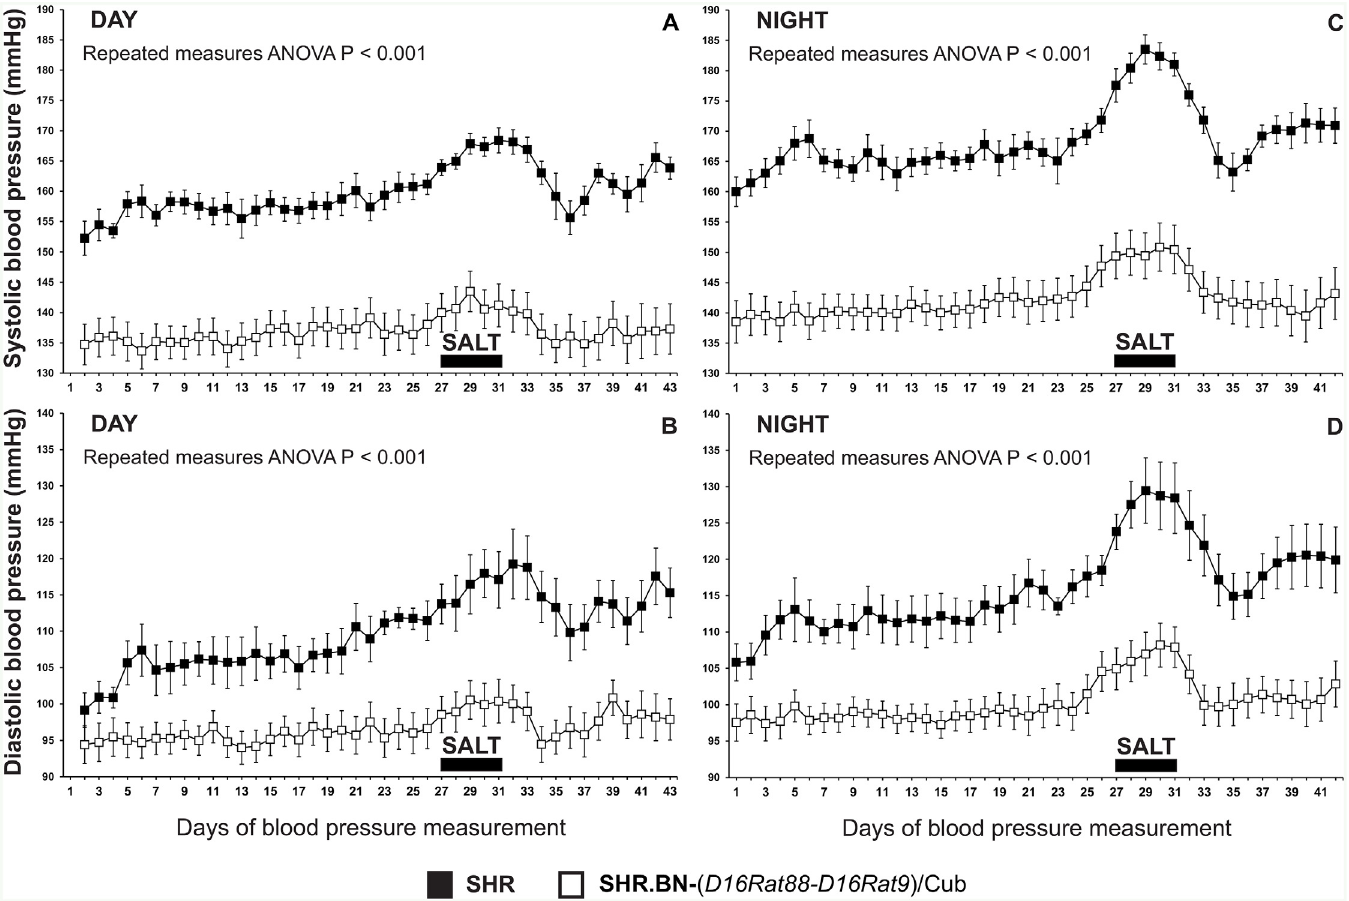
Fig 3. Radiotelemetric blood-pressure assessment in adult male SHR and SHR.BN16 rats. A significant reduction in systolic (Panels A, C) and diastolic (Panels B, D) blood pressure was observed in the SHR.BN-( D16Rat88-D16Rat9 )/Cub rats during both the daytime (Panels A, B) and the night-time (Panels C, D), as well as under salt load (indicated by a full horizontal bar) (repeated-measures ANOVA, P < 0.001).